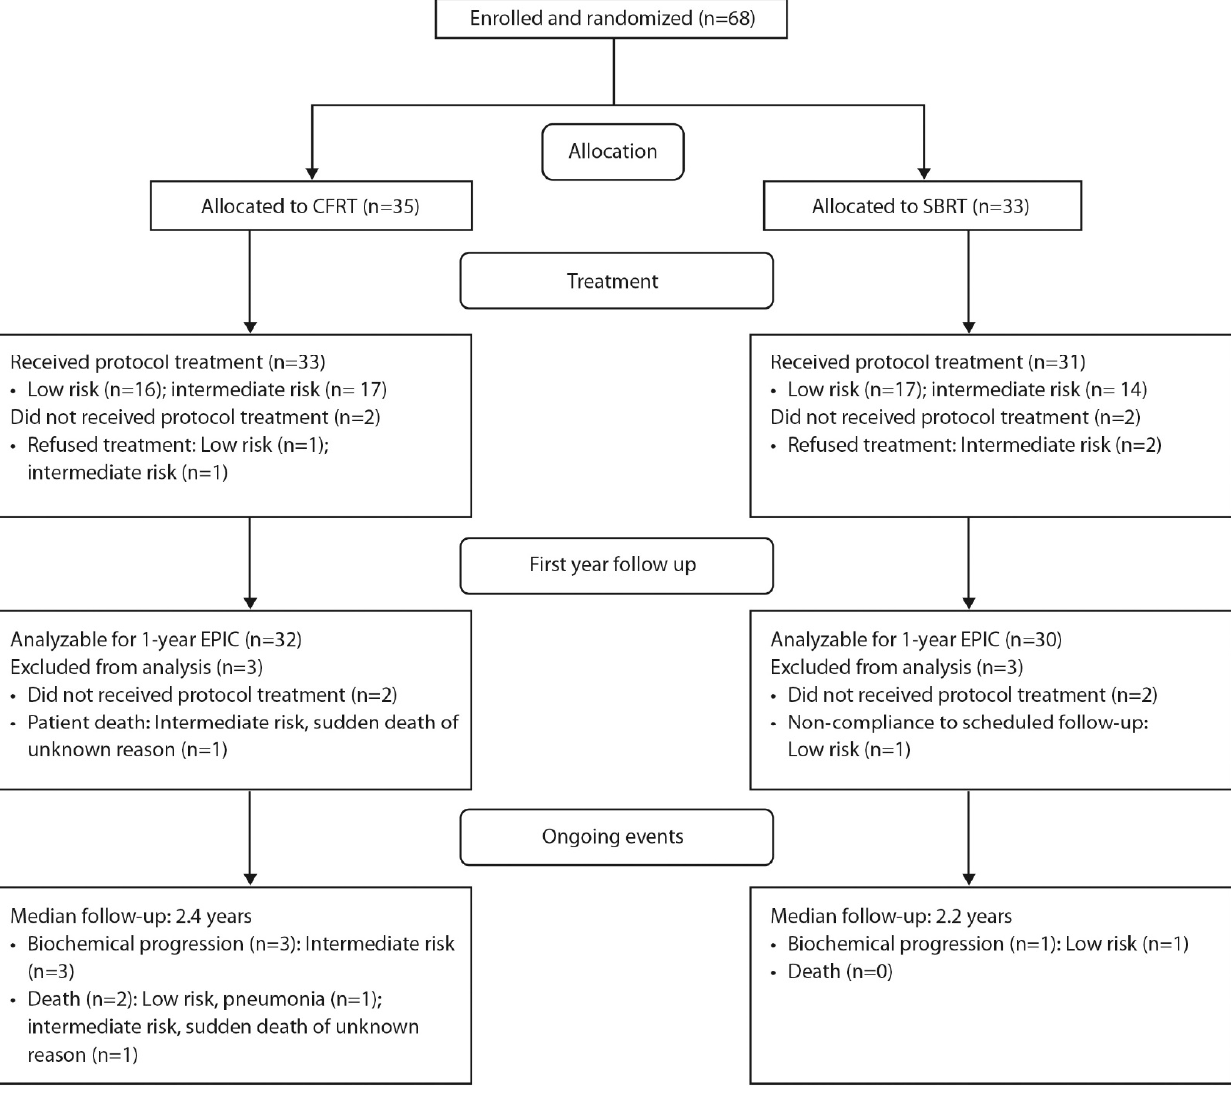
Figure 1. CONSORT diagram showing enrollment, random assignment and follow-up of the study participants. Abbreviations: SBRT, stereotactic body radiotherapy; CFRT, conventional fractionated radiotherapy; EPIC, Expanded Prostate Cancer Index Composite questionnaire. Table 1. Patient baseline characteristics.